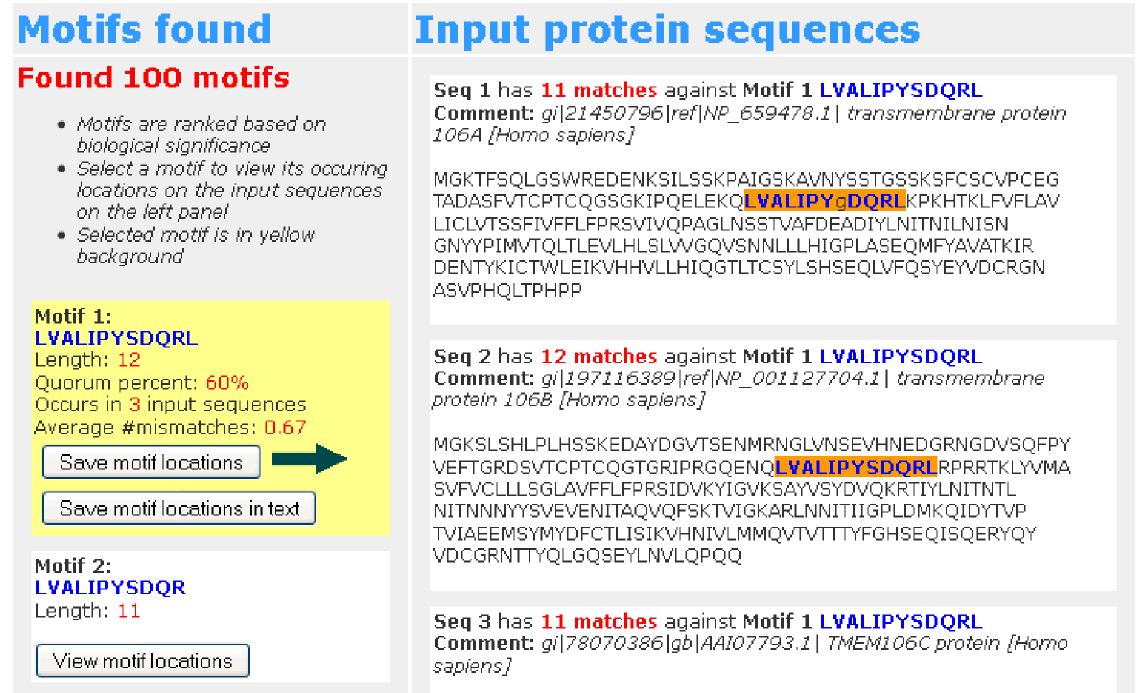
Figure 5. Result available - Protein sequences. An example of the results page when the submission is processed. The locations of the second motif are marked on the protein input sequences.